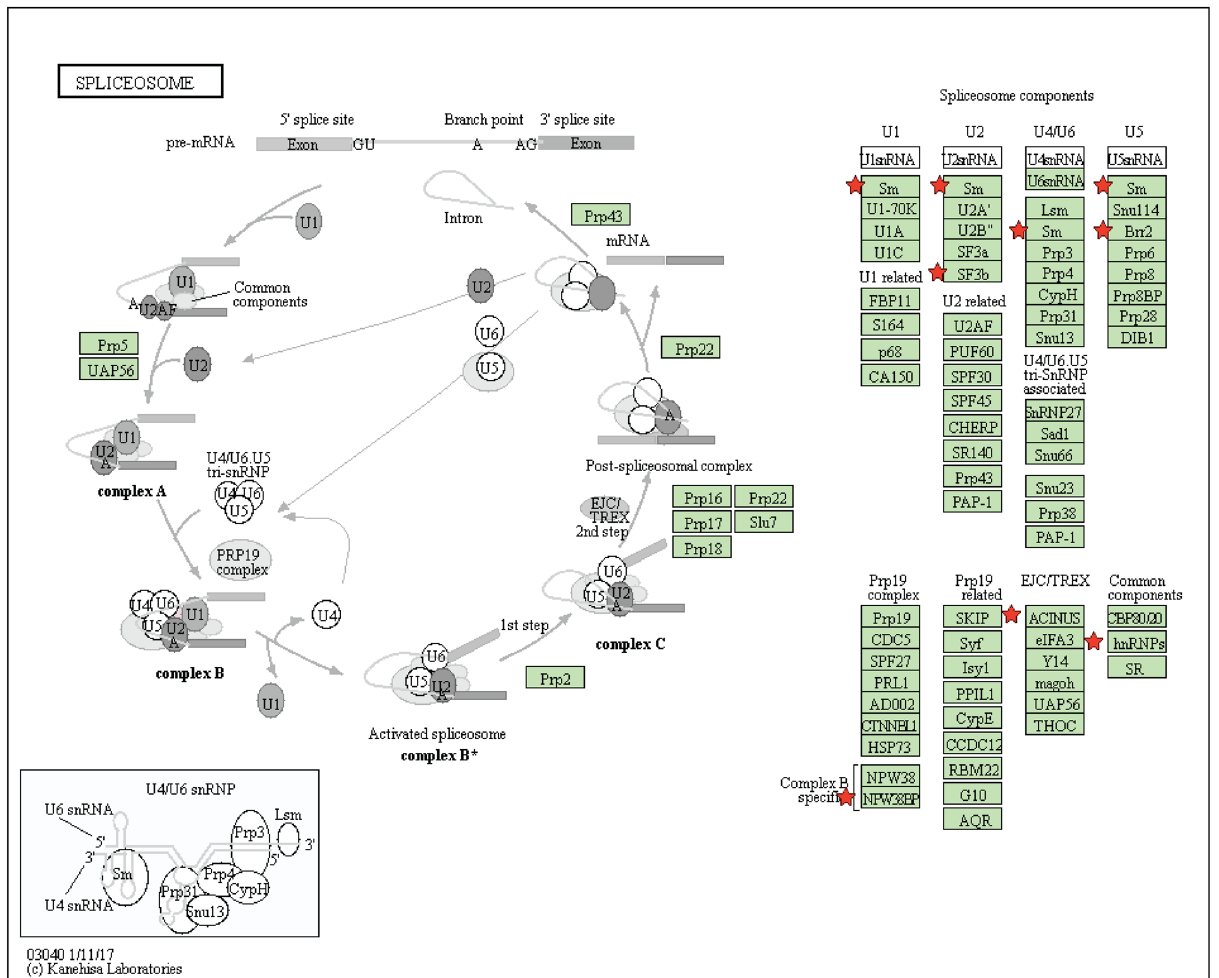
Figure 4. KEGG pathway enrichment analysis of the acetylated proteins in the spliceosome. KEGG pathway enrichment analysis of acetylated proteins both upregulated 1.5-fold following SIRT2 knockdown and downregulated 1.5-fold following SIRT2 overexpression that function in the spliceosome. Red stars indicate the hits from the present